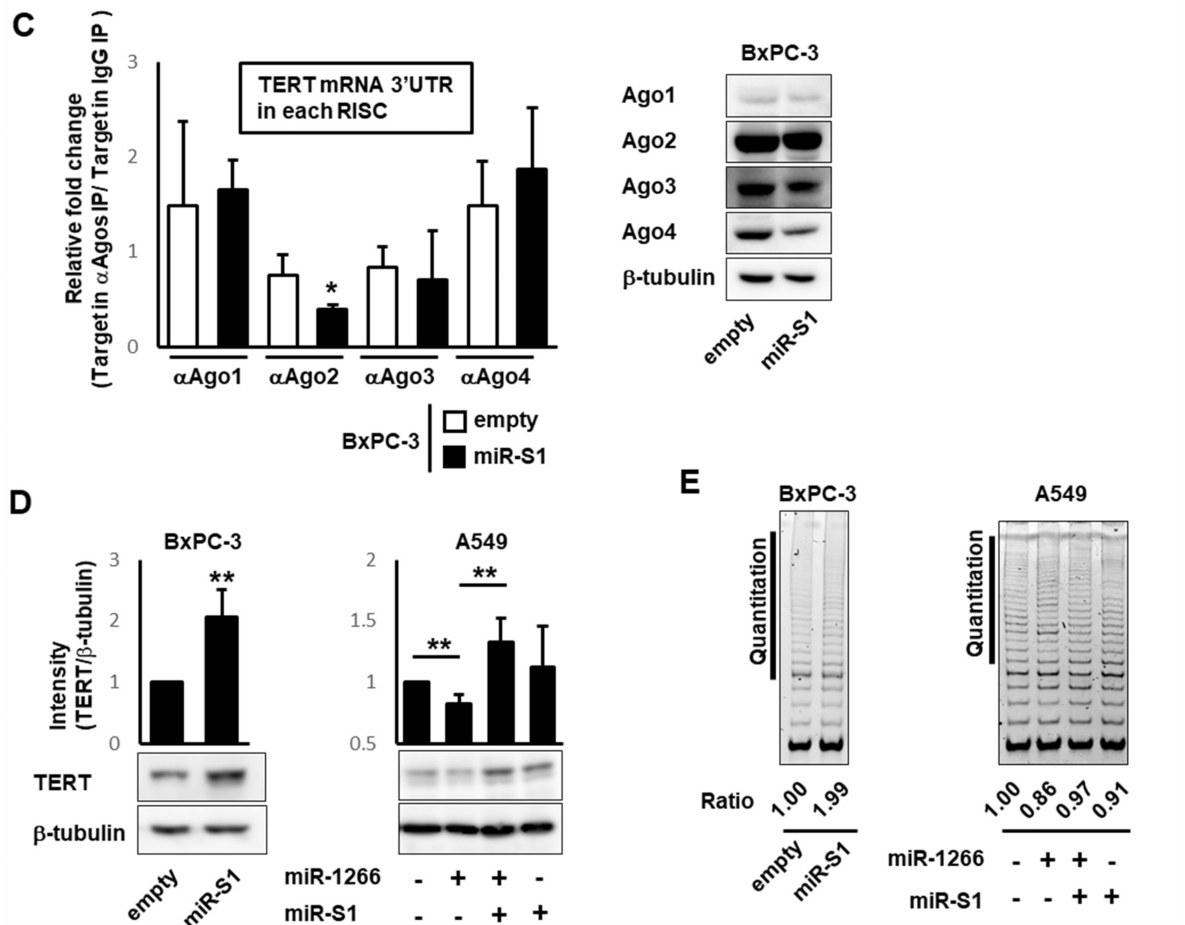
Figure 4. MiR-S1 upregulates TERT levels through competitive antagonism with miR-1266. ( A ) HEK293 cells were cotransfected with the internal pGL control vector and pRL-Luc, pRL-Luc- hTERT-3 (cid:48) UTR, or pRL-Luc-hTERT-3 (cid:48) UTR mt, and CMV-miR-1266-PGK-puro at a molar ratio of 1:5:25. The relative luciferase activities were calculated by dividing the value of pRL by the value of pGL. All values were normalized by empty CMV-cont-PGK-puro-transfected cells. The sequence of the mutated region of pRL-Luc-hTERT-3 (cid:48) UTR mt was also shown (underlined). Further, control and miR-1266 − expressing cells were further transfected with pZac-hTERT-HA-3 (cid:48) UTR. The levels of HA in the resultant transfectants were determined by immunoblot analysis. Each experiment was repeated two (immunoblot analysis) or three (reporter assay) times. Columns, mean values ( n = 3); bars, SD; * p < 0.05; ** p < 0.01. ( B ) HEK293 cells were cotransfected with the internal pGL control vector, pRL-Luc-hTERT-3 (cid:48) UTR, and miRNA expression vectors at a total molar ratio of 1:5:25. The relative luciferase activities were calculated by dividing the value of pRL by the value of pGL. All values were normalized by corresponding empty vector-transfected cells. All experiments were repeated three times. Columns, mean values ( n = 3); bars, SD; * p < 0.01. ( C ) Lysates from control and miR-S1-expressing BxPC-3 were also treated with anti − Ago1, Ago2, Ago3, and Ago4 antibodies before being precipitated with protein G-conjugated magnetic beads, and RNAs were isolated. Using these RNAs, the level of TERT mRNA 3 (cid:48) UTR was determined by RT-qPCR. Columns, mean values ( n = 3); bars, SD; * p < 0.05. The levels of Ago1, Ago2, Ago3, and Ago4 in control and miR-S1- expressing BxPC-3 were also determined by immunoblot analysis. ( D ) Levels of endogenous TERT protein in BxPC-3- and A549-derived infectants were determined using immunoblot analysis. The levels of TERT protein (TERT/beta-tubulin) were calculated using ImageJ software. All experiments were repeated three times. Columns, mean values ( n = 4); bars, SD; ** p < 0.01. ( E ) Cellular TERT activities in BxPC-3 − and A549 − derived infectants were measured using the TRAP assay. TRAP reactions were conducted by 50 cells (BxPC-3) or 80 cells (A549) per reaction, respectively. Using ImageJ software, specific activities were calculated by quantifying the intensity of ladder bands at vertical lines (middle − long telomeric repeats). All experiments were repeated two